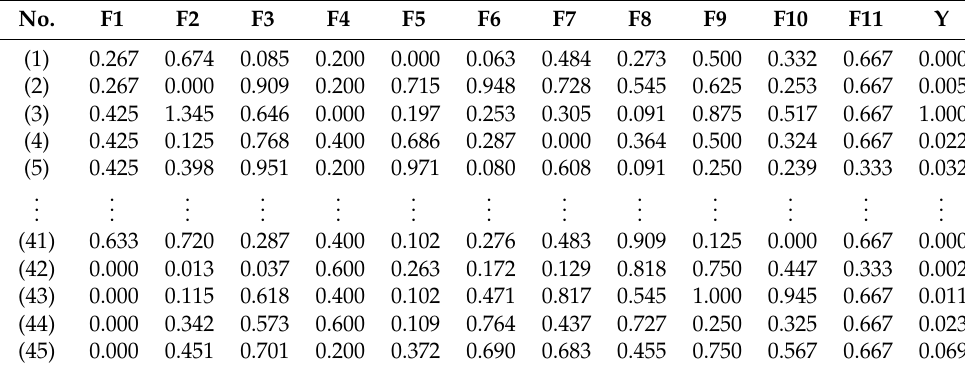
Table 7. Engineering data after pretreatment.